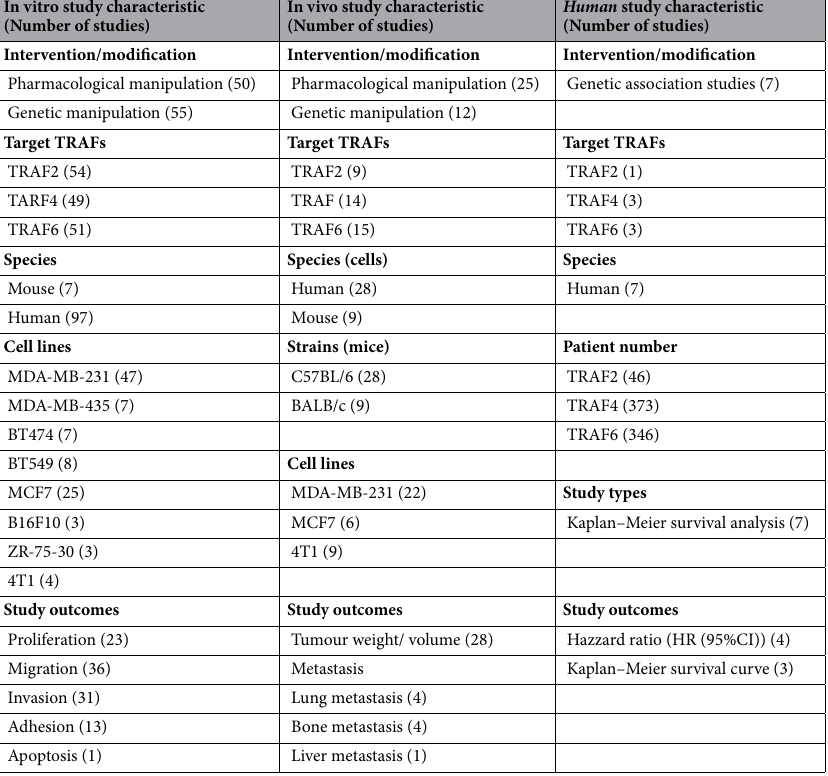
Table 1. Summary the number and characteristics of included in vitro, in vivo , and human